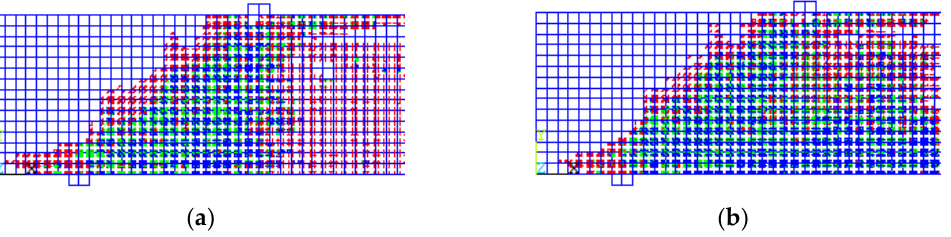
Figure 6. Crack Patterns for the Verification Models. ( a ) Control Specimen at Failure Load = 304.9 KN. ( b ) BCFA at Failure Load = 359.3 KN.